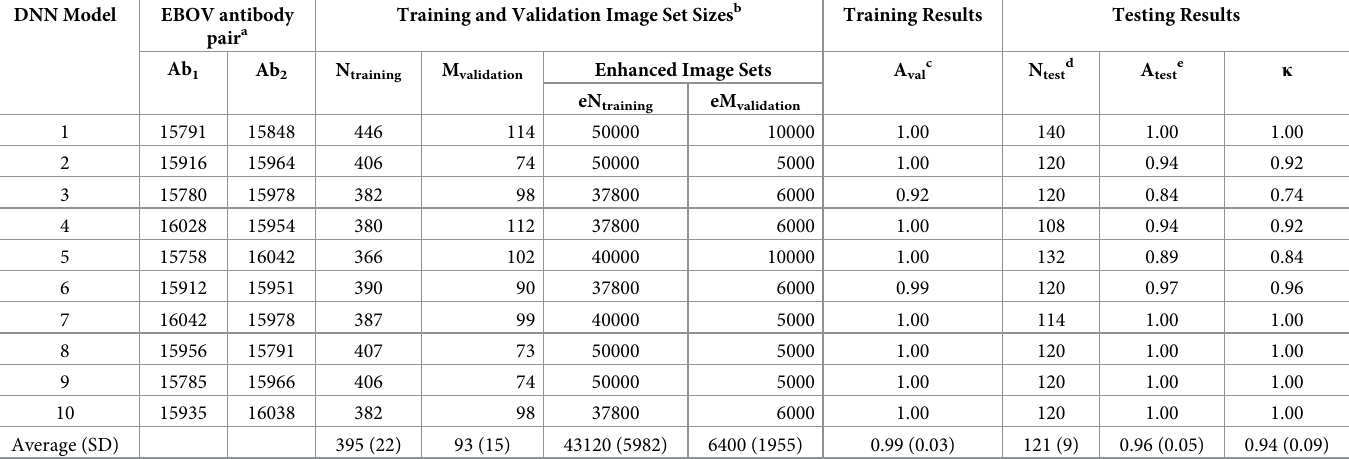
Table 2. Summary of 10 DNN models trained to differentiate between fingerprints belonging to pairs of antibodies. Fingerprints were generated using the charge col- oring scheme shown in Fig 1. DNN Model EBOV antibody pair a